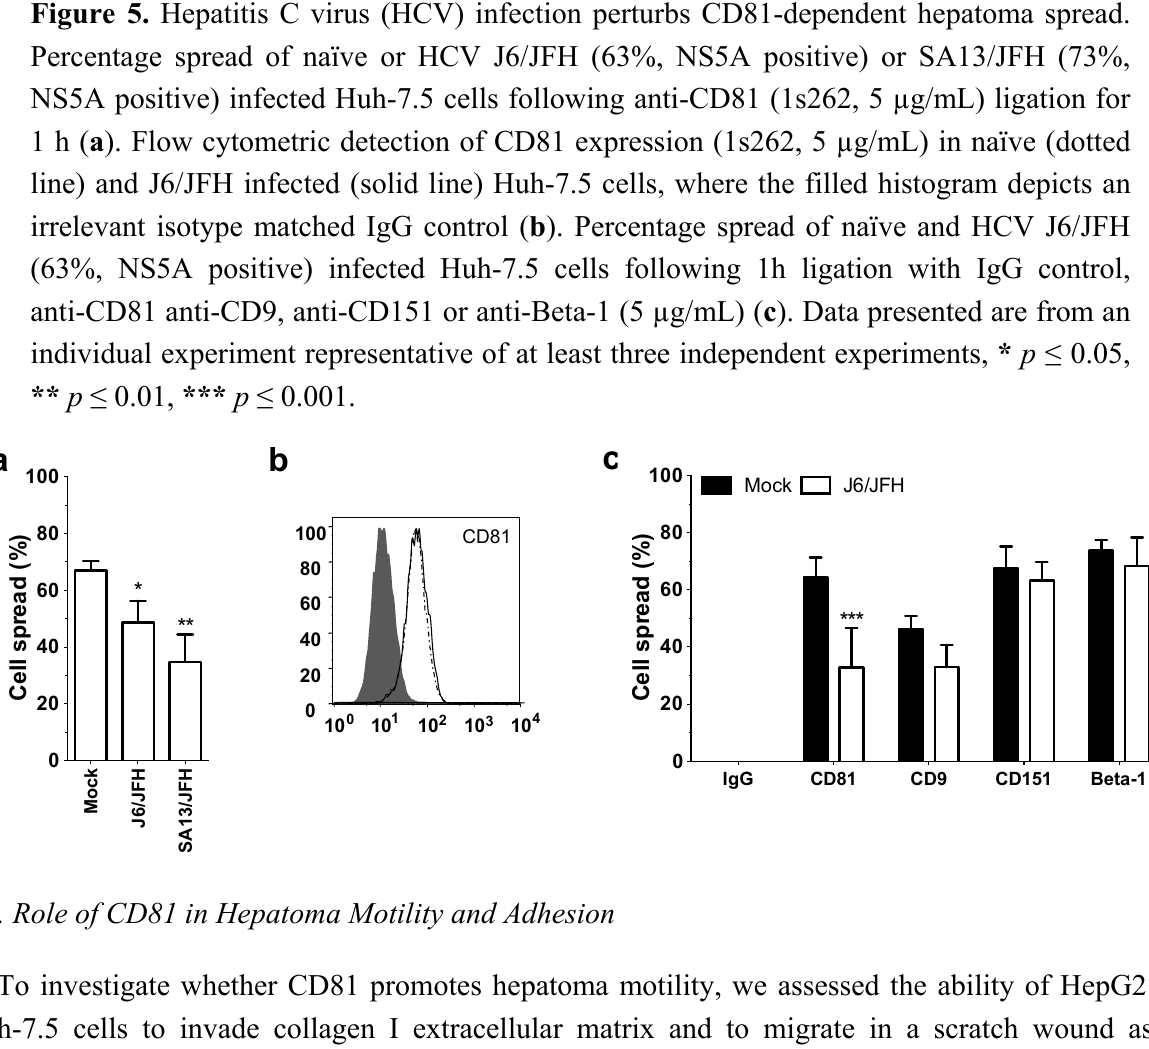
Figure 5. Hepatitis C virus (HCV) infection perturbs CD81-dependent hepatoma spread. Percentage spread of naïve or HCV J6/JFH (63%, NS5A positive) or SA13/JFH (73%, NS5A positive) infected Huh-7.5 cells following anti-CD81 (1s262, 5 µg/mL) ligation